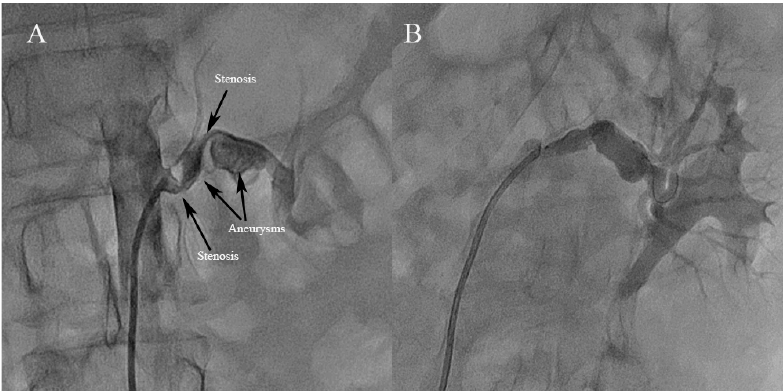
Figure 2. Examples of multifocal fibromuscular dysplasia simultaneously involving two stenoses on a given vascular segment and aneurysm ( A , B ) showing an improvement in the angiographic appearance as the result of successful percutaneous transluminal renal angioplasty.